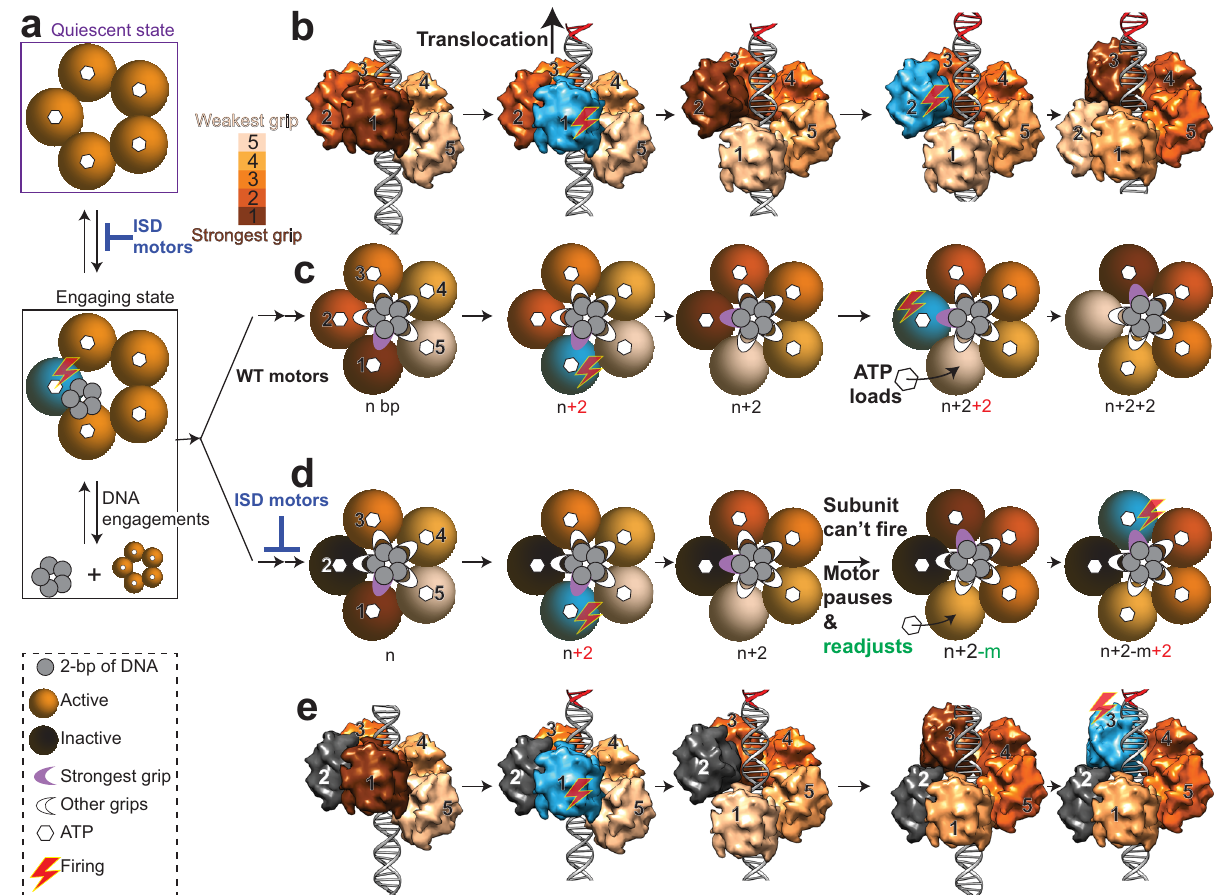
Fig. 5 A model for DNA translocation and subunit coordination by phage T4 DNA packaging motor. a The pentameric gp17 DNA packaging motor ( fi ve brown circles) alternates between a quiescent state and a DNA engaging active state when exposed to short 45-bp oligonucleotide DNA substrate (gray circles), with the ISD motor spending longer time in quiescent state than the WT motor (shown by blue deleterious symbol). b The pentameric motor adapts to DNA helix by interacting at ~2-bp intervals, leading to different subunits binding at different strengths, as shown by increasing color intensity with increasing strength of the grip. The surface view of the putative DNA-binding C-terminal domain of gp17 is used to illustrate DNA – motor interactions. Shown are the side views with the camera facing subunit #1. See Supplementary Video 1 for additional details. The subunit with the strongest grip (#1; cyan) fi res ATP, causing 2-bp DNA translocation ( n + 2). The adjacent subunit (#2) now attains the strongest grip, while the apo subunit (no ATP) re- loads ATP. The #2 subunit now fi res, causing another 2-bp translocation ( n + 2 + 2) and this cycle continues. c Cartoon schematic of b depicting the motor ’ s top view. DNA is shown in gray in the motor ’ s channel, with each small circle representing 2-bp of DNA. White arches represent DNA-binding grips, while the purple arches represent the strongest grips. Hexagons at the center of each subunit represent bound ATP. b , c correspond to WT motor, while d , e correspond to ISD motor. When an inactive motor subunit (black; subunit #2) is encountered ( d , e ), the motor pauses and readjusts DNA grip, which might involve backward DNA movement ( “ m ” bp). The subunit with the strongest grip (#3) then fi res causing DNA translocation and the cycle continues. The shapes depicted in the fi gure are shown in the bottom left corner of the fi subunits (Fig. 3b, right panel). But the overall frequency of DNA